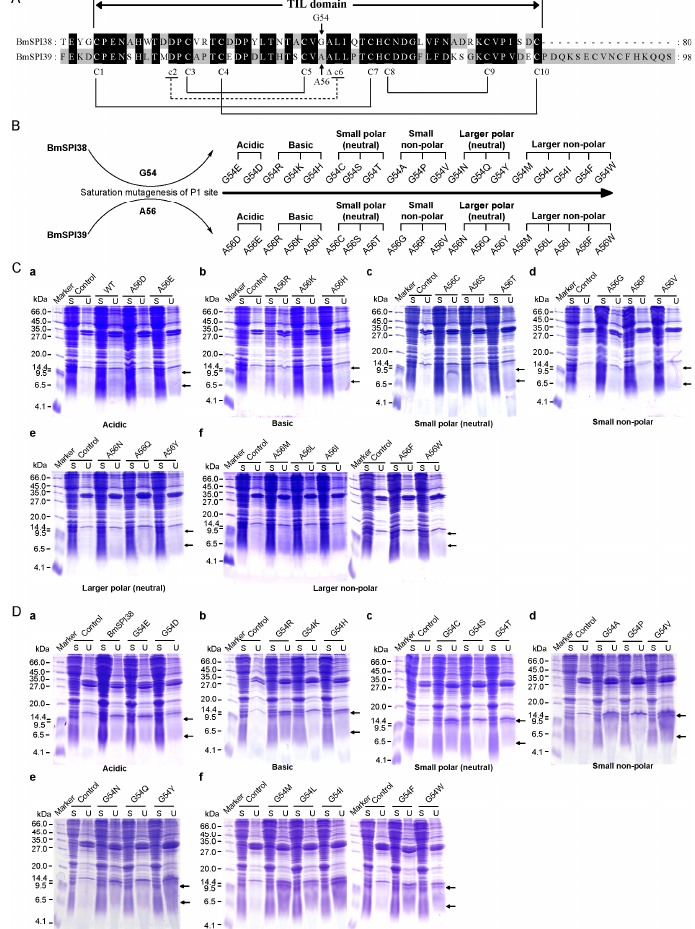
Figure 2. Design, expression vector construction and prokaryotic expression of the P1 mutants of BmSPI38 and BmSPI39. ( A ) The P1 residues and the conserved cysteines in the TIL domain of BmSPI38 and BmSPI39. The eight conserved cysteines are shown with capital C. “c2” and “c6” indicate the second and sixth conserved cysteines missing from the TIL domain of BmSPI38 and BmSPI39, respectively. The four intramolecular disulfide bonds formed by conserved cysteines are shown as black solid lines. The missing disulfide bond between Cys 2nd and Cys 6th is shown as a dashed line. The P1 and P1 (cid:48) residues in the reactive centers are indicated by arrows and empty triangles, respectively. Gly54 and Ala56 are putative P1 residues of BmSPI38 and BmSPI39, respectively. ( B ) Schematic representation of saturation mutagenesis at P1 position of BmSPI38 and BmSPI39. ( C ) Prokaryotic expression of the P1 mutants of BmSPI39. SDS-PAGE analysis of BmSPI39 mutants with acidic ( a ), basic ( b ), small polar (neutral) ( c ), small non-polar ( d ), larger polar (neutral) ( e ), and larger non-polar ( f ) amino acids at P1 position. The theoretical molecular weights of the monomer and dimer of the BmSPI39 mutant proteins are about 9.3 kDa and 18.6 kDa, respectively. The arrows show the recombinant BmSPI39 mutant proteins. The upper arrow indicates the band corresponding to the dimer of the BmSPI39 mutant protein and the lower arrow indicates the band corresponding to its monomer. ( D ) Prokaryotic expression of the P1 mutants of BmSPI38. SDS-PAGE analysis of BmSPI38 mutants with acidic ( a ), basic ( b ), small polar (neutral) ( c ), small non-polar ( d ), larger polar (neutral) ( e ), and larger non-polar ( f ) amino acids at P1 position. The theoretical molecular weights of the monomer and dimer of the BmSPI38 mutant proteins are about 7.5 kDa and 15 kDa, respectively. The arrows show the recombinant BmSPI38 mutant proteins. The upper arrow indicates the band corre-sponding to the dimer of the BmSPI38 mutant protein and the lower arrow indicates the band corresponding to its